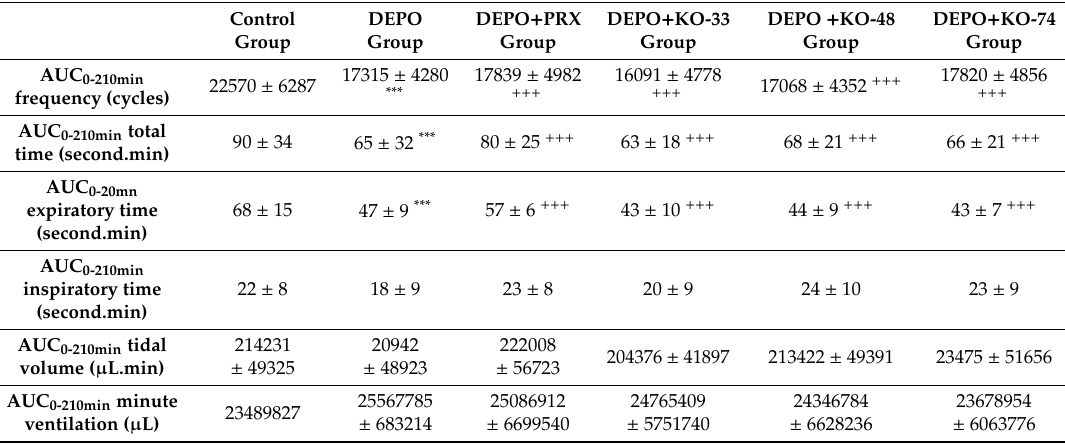
Table 4. Values of AUC from 0 to 210 min for respiratory parameters. Each group was constituted of eight rats. Data are represented by mean ± S.E.M. at each time after injection. Diethyl-paraoxon (DEPO) vs. Control: *** p < 0.001. Diethyl-paraoxon (DEPO) + oximes vs. Control: +++ p <